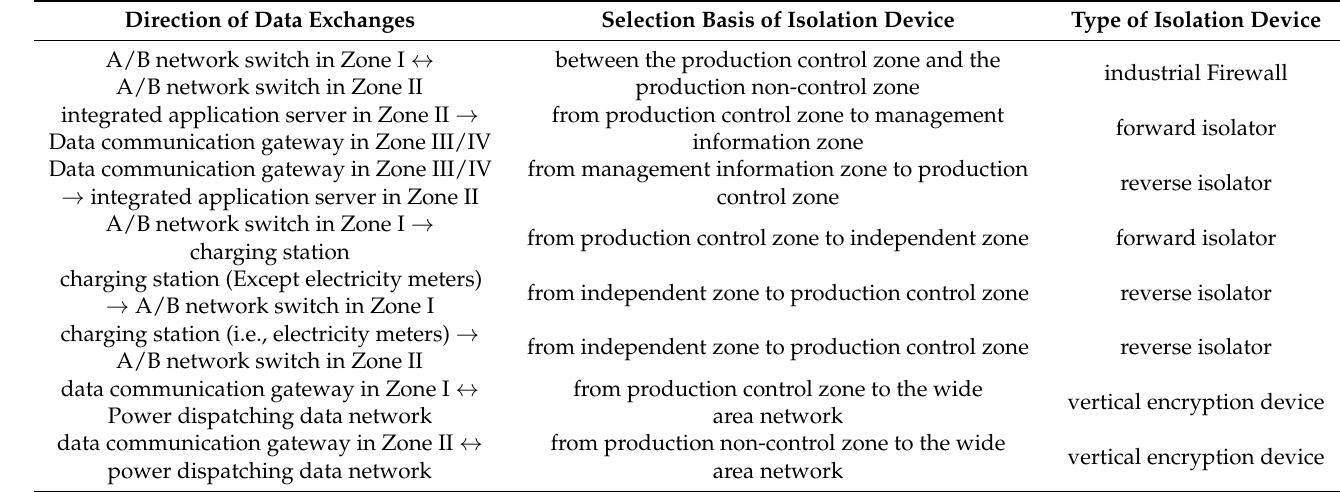
Table 2. Selection for isolation